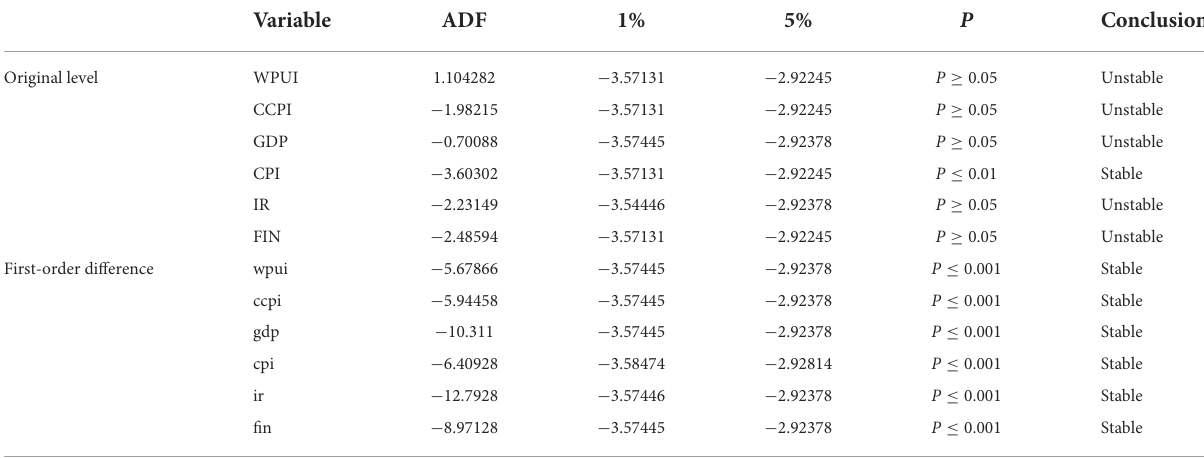
TABLE 1 Unit root ADF test results.